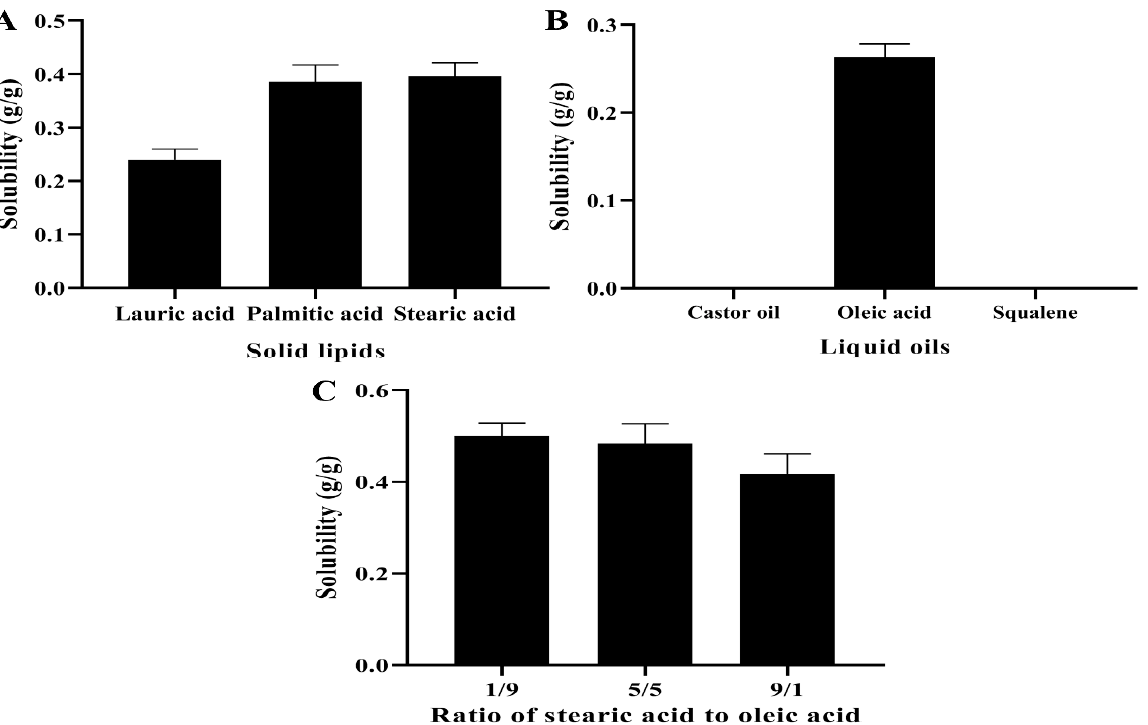
Figure 1. Screening of the solid and liquid lipids for the solubility of MAD. ( A ) Solubility of MAD was determined in different solid lipids. ( B ) Solubility of MAD was analyzed in various liquid lipids. ( C ) Solubility of MAD was detected in varied ratios of stearic acid and oleic acid.